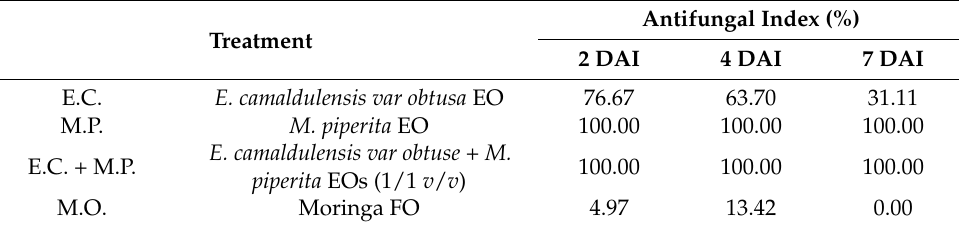
Figure 4. In vitro antifungal activity of the tested oils against B. cinerea. ( a ) control; ( b ) moringa FO; ( c ) E. camaldulensis var obtusa EO; ( d ) M. piperita EO; ( e ) combination of E. camaldulensis var obtuse – M. piperita (1/1 v / v ) EOs. Table 6. Antifungal activity of M. piperita , E. camaldulensis var obtuse and their combination and moringa oils against B. cinerea .